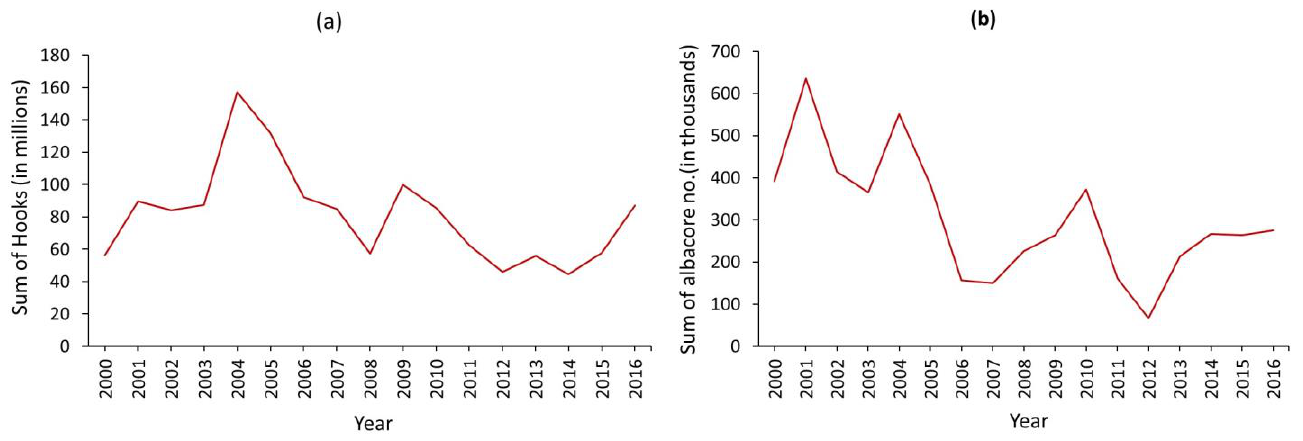
Figure 9. ( a ) Effort and ( b ) number of albacore captured from 2000 to 2016 in the southern Indian Ocean.